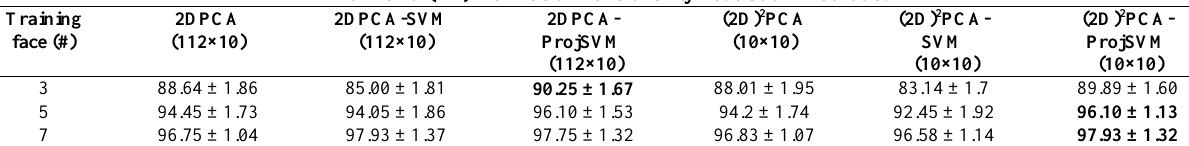
Table 1. Mean classification accuracy (in percent) over 10 random runs for ORL dataset with reduced dimension of 10 using 2DPCA and (2D) 2 PCA as dimensionality reduction